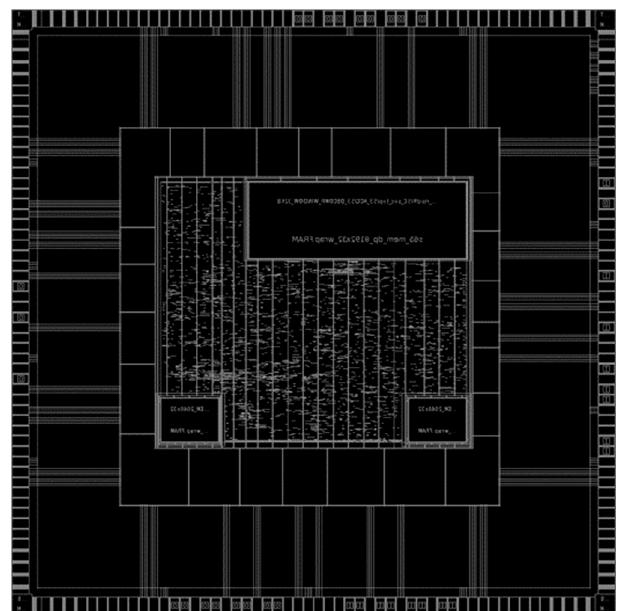
Figure 4. Layout of SoC with LDA.